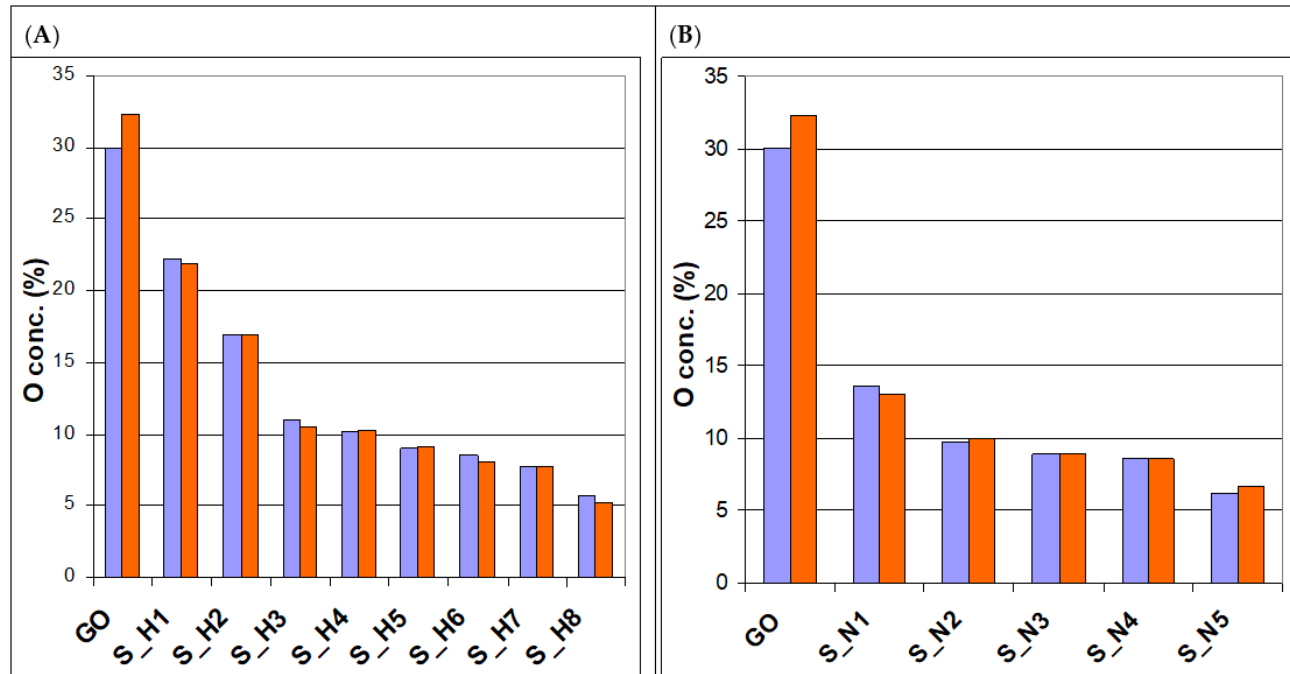
Figure 4. Trend of the total oxygen concentrations (blue) and of the concentration of oxygen derived from the C1s fit and carbon oxidized fit components of carbon (red) in rGO reduced using HI ( A ) or NaBH 4 ( B